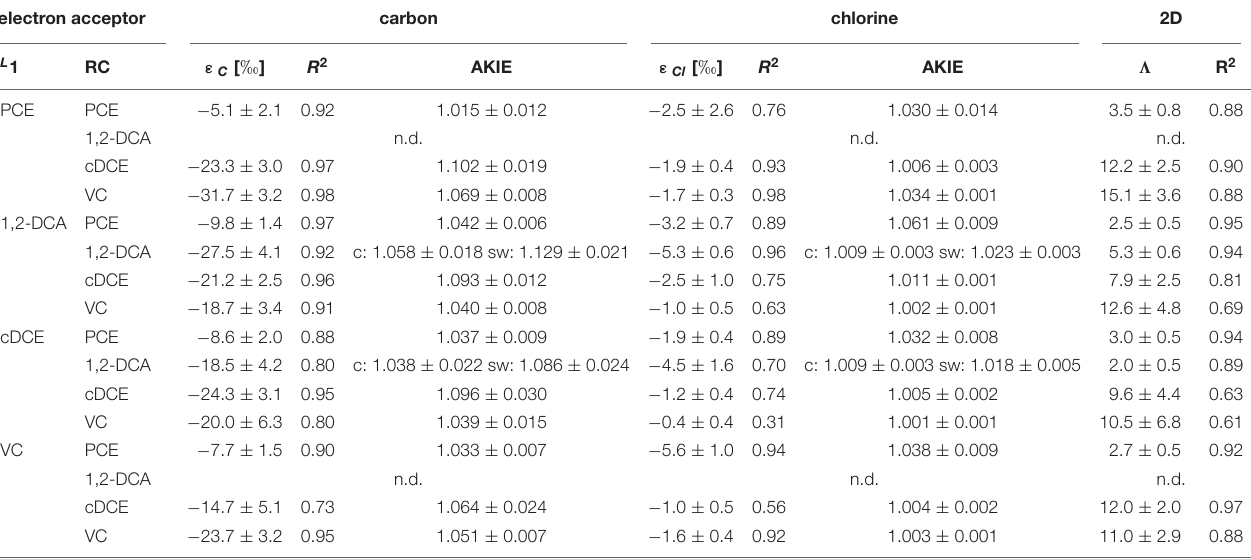
TABLE 3 | Summary of isotope fractionation